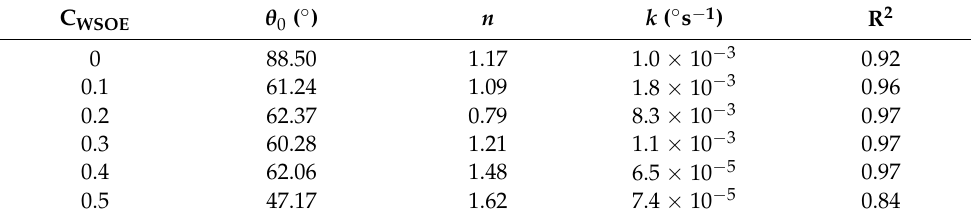
Table 2. Effect on the kinetic parameters using the model of Farris et al. [29] of cross-linked cassava starch-based films with different concentrations of watermelon seed oil emulsions (C WSOE , g/100 g of film-forming solution). C